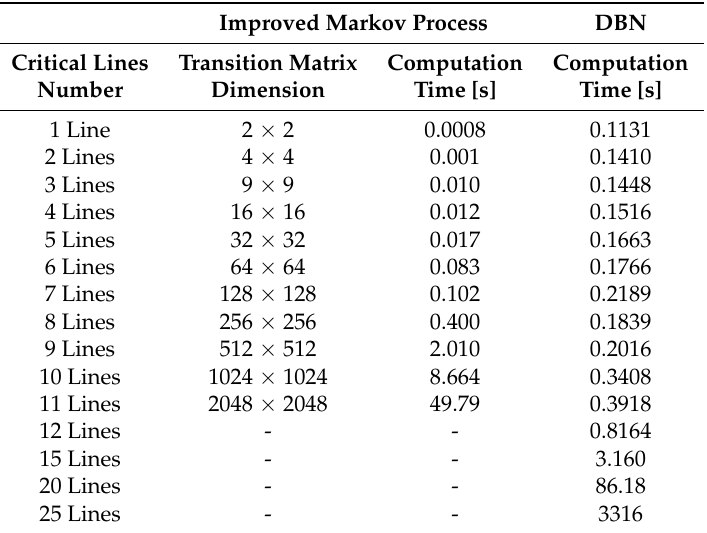
Table 4. Table Type